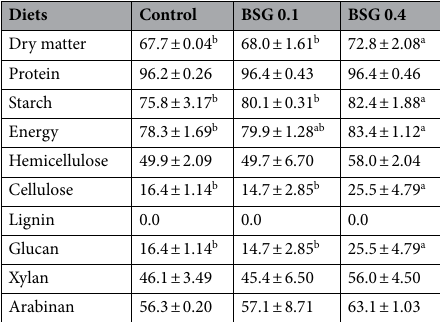
Table 7. Apparent digestibility coefficients (ADC) of dietary nutrients and energy in European seabass juveniles fed with the experimental diets. Values presented as mean (n = 3) and standard deviation (SD). Values in the same row with different subscripts are significantly different ( p <